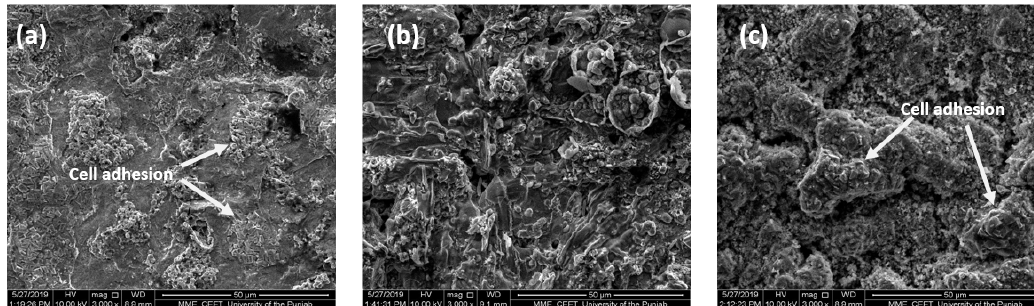
Figure 10. SEM images of specimens after cytotoxicity assessment ( a ) S1 ( b ) S3 and ( c ) S5.